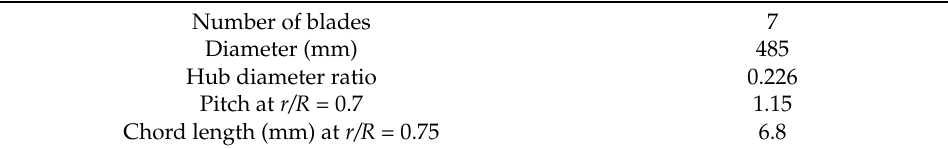
Table 8. E1619 propeller particulars.